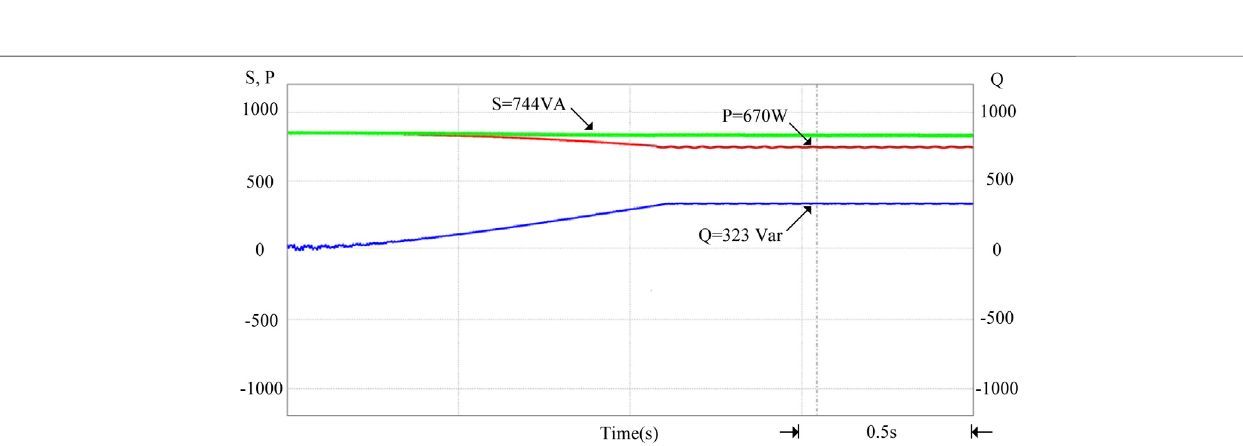
Frontiers in Energy Research |